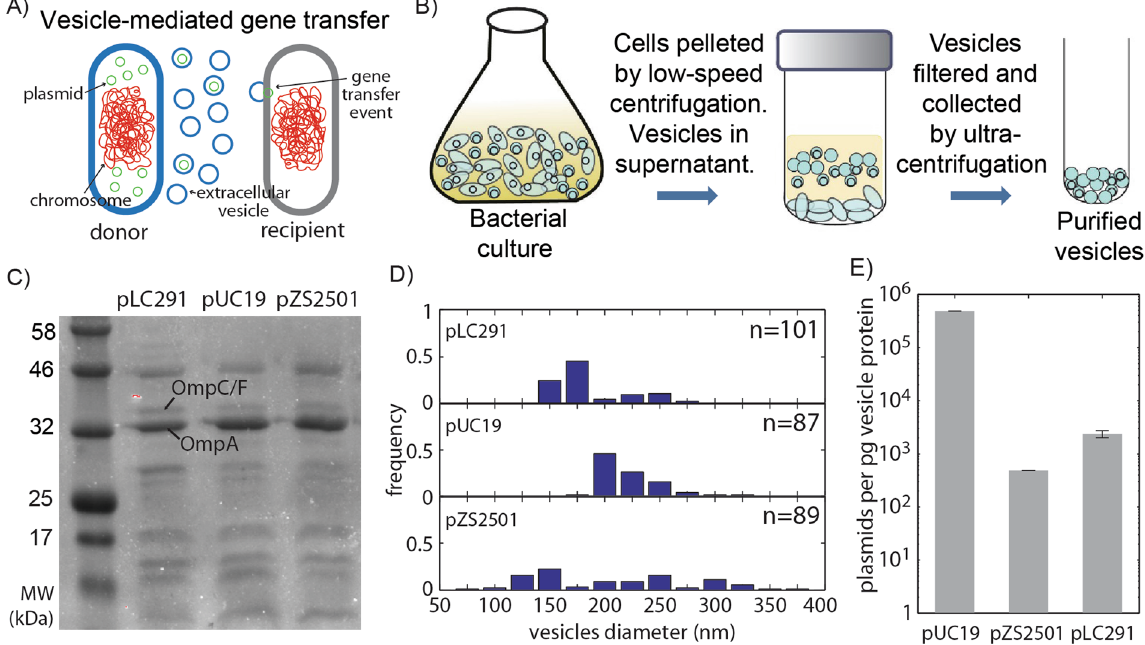
Figure 1. The impact of plasmid identity on the production and packaging of plasmid-containing vesicle. ( A ) Vesicle-mediated gene transfer. Donor cells load plasmid DNA into EV vesicles that can be acquired by a recipient cell. ( B ) Purification of EVs from liquid culture of bacterial cells through ultracentrifugation of cell-free supernatant. ( C ) 10% SDS-PAGE gel stained with Coomassie Blue showing concentration of outer membrane proteins, OmpA and OmpC/F, from EVs. ( D ) Distribution of EV diameters measured by dynamic light scattering. ( E ) Vesicle DNA content per pg of vesicle protein quantified by qPCR. P-value for all paired plasmid comparisons < 0.001. Error bars signify standard